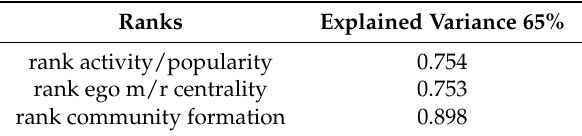
Table 3. PCA resulting to one PC, to ensure unidimentionality of the three ranks.